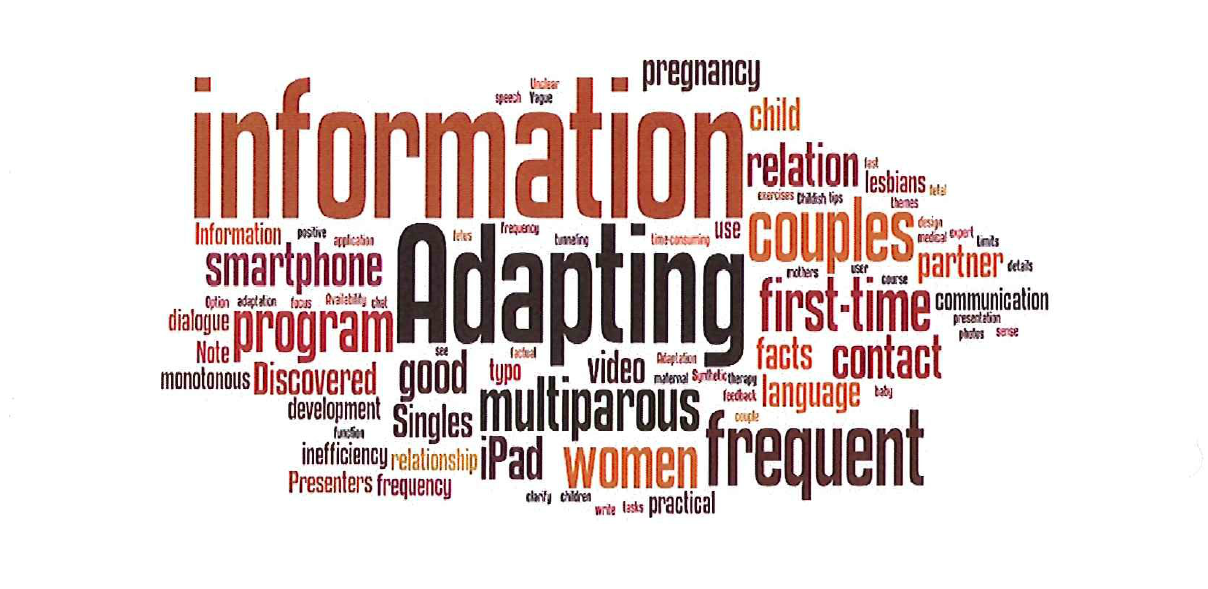
Figure 1. De-contextualized word cloud analysis of suggested